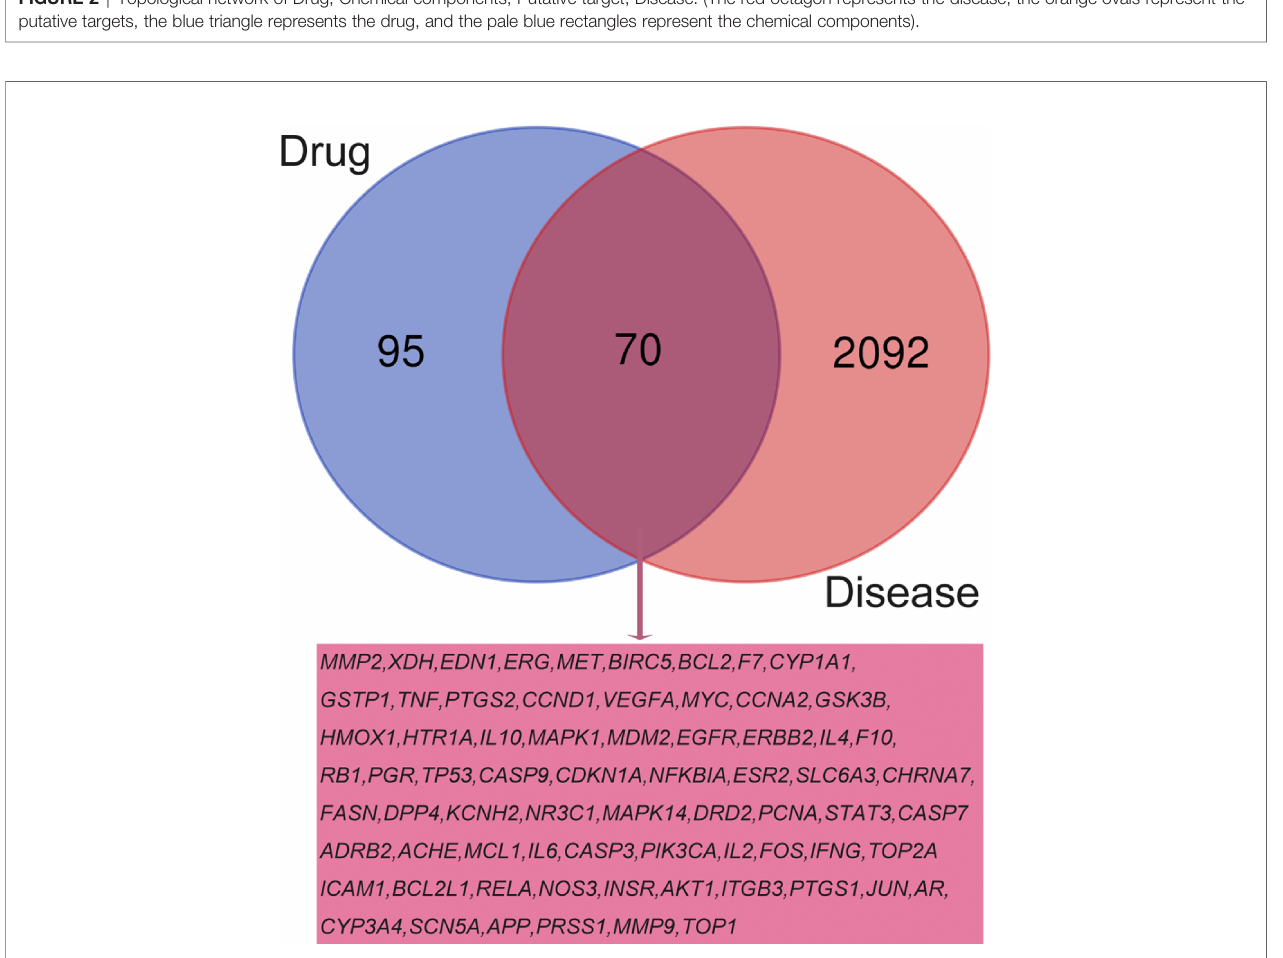
FIGURE 3 | Venn diagram for drug prediction of target genes and disease-related